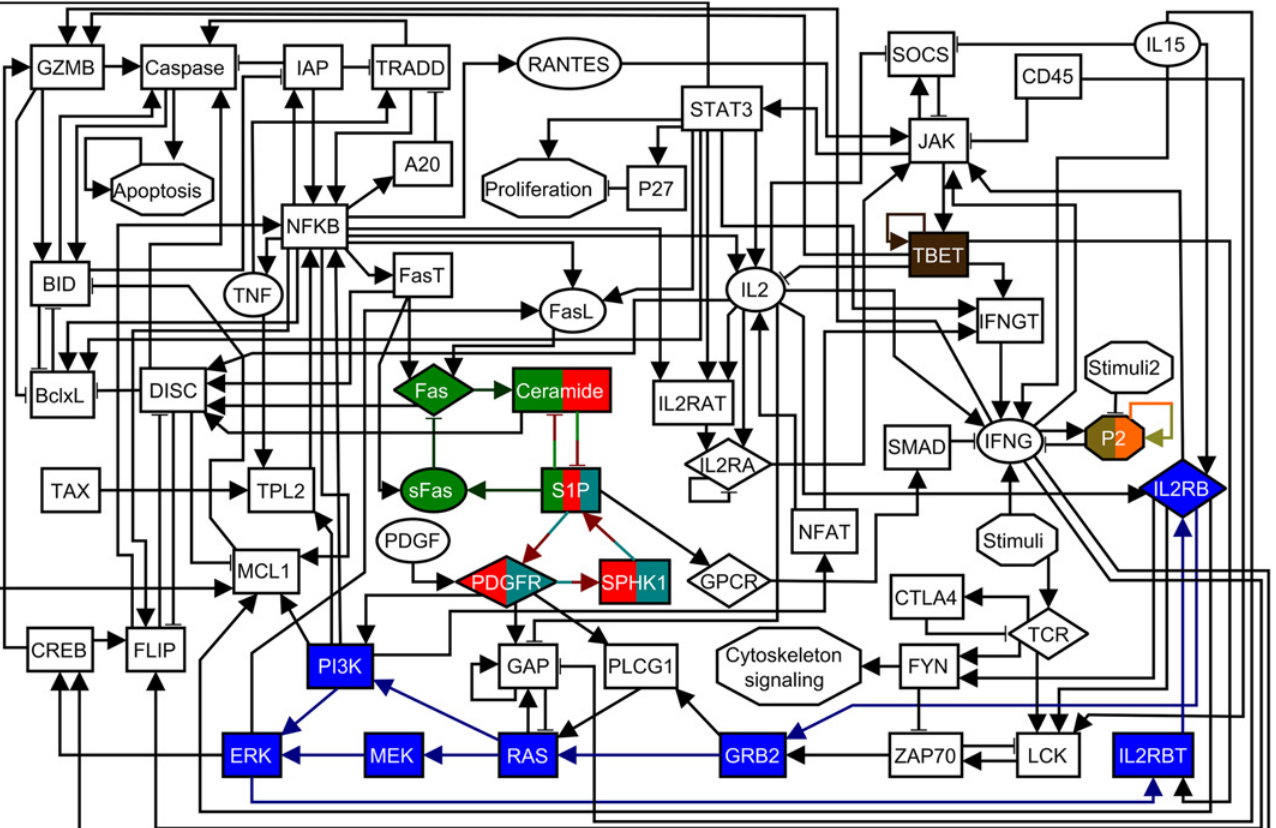
Fig 3. The T-LGL leukemia survival signaling network. The shape of the nodes indicates the cellular location or the type of nodes: rectangles indicate intracellular components, ellipses indicate extracellular components, diamonds indicate receptors, and hexagons represent conceptual nodes (Stimuli, Stimuli2, P2, Cytoskeleton signaling, Proliferation, and Apoptosis). Node colors are used to denote the different stable motifs of the network in the presence of the external signals Stimuli and IL15. Nodes and edges with multiple colors are part of several stable motifs. An arrowhead or a short perpendicular bar at the end of an edge indicates activation or inhibition, respectively. This figure and its caption are adapted from